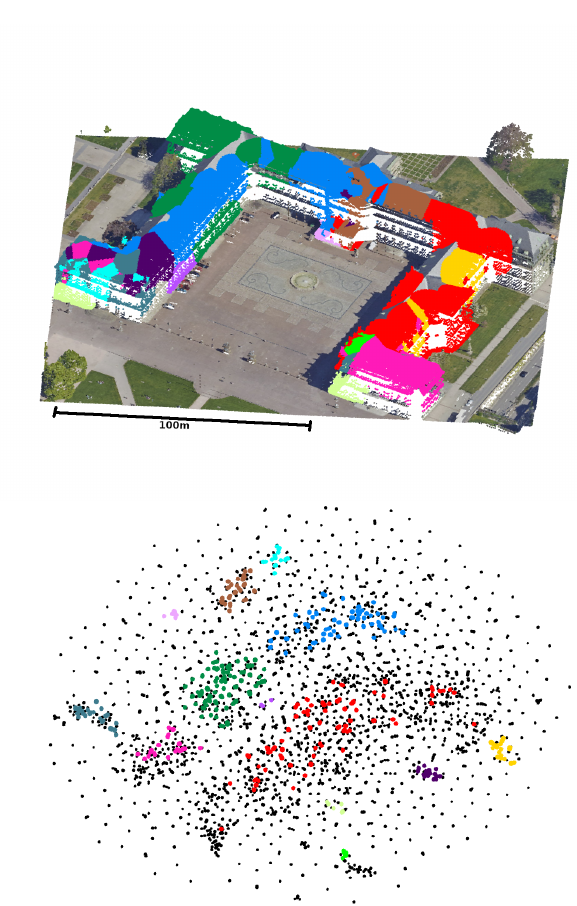
Figure 10. Top: ALS point cloud with colored clusters on Building B. Bottom: Corresponding t-SNE embedding. The related time series are given in Figure 11.